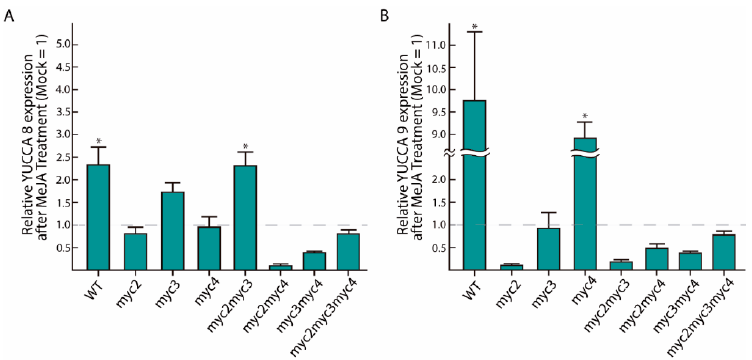
Figure 2. MYC2, MYC3, and MYC4 contribute to the control YUC8 and YUC9 expression in response to MeJA. Depicted is the qRT-PCR analysis of ( A ) YUC8 and ( B ) YUC9 expression after MeJA- treatment (4 h and 2 h for YUC8 and YUC9 , respectively). The transcript levels of YUC8 and YUC9 are given relative to the reference genes UBI10 and APT1 and normalized using the mock treated seedlings (0.5% MeOH ( v / v )). The data shown are mean ± SE ( n = 3). We established a two-fold change between the mock treated seedlings and the respective MeJA-treated seedlings as threshold to assume a differential regulation (* fold-change ≥